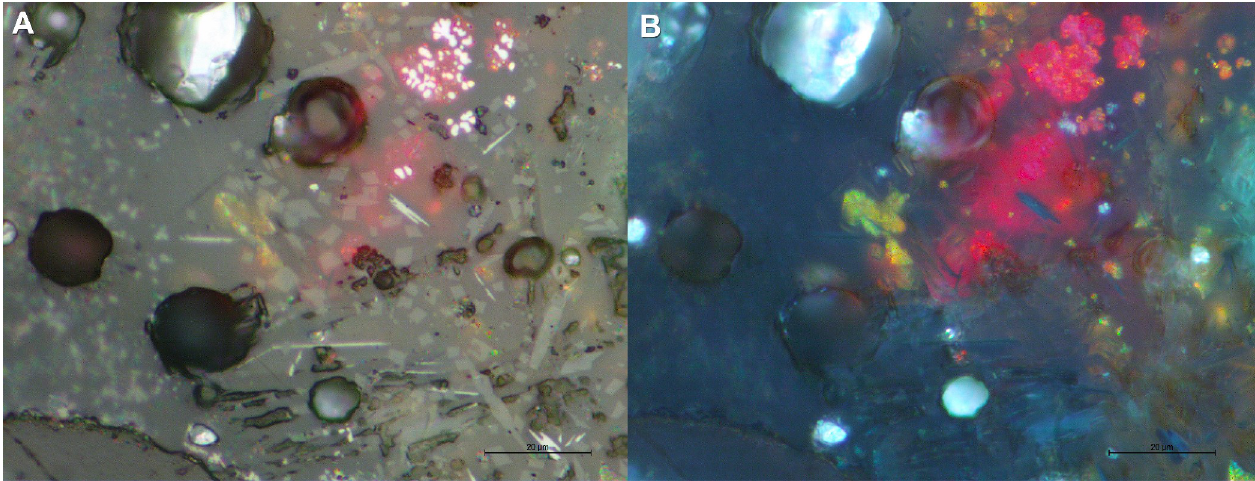
Fig 16. PPL (A) and XPL (B) micrographs of E13 showing a bright metallic Cu cluster (top right, Fig 13A) being re-oxidised into red cuprite (top right, Fig 13B). On Fig 13A, white needles were identified as delafossite, light grey crystals as Fe aluminosilicates, and dark grey crystals as anorthite. (Scales = 20 μ m).